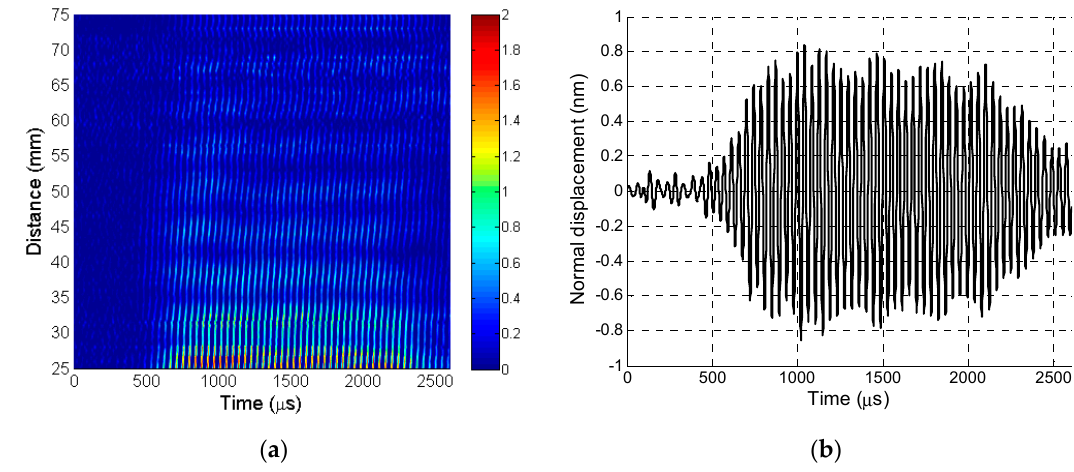
Figure 9. Frequency response of the Gaussian filter.